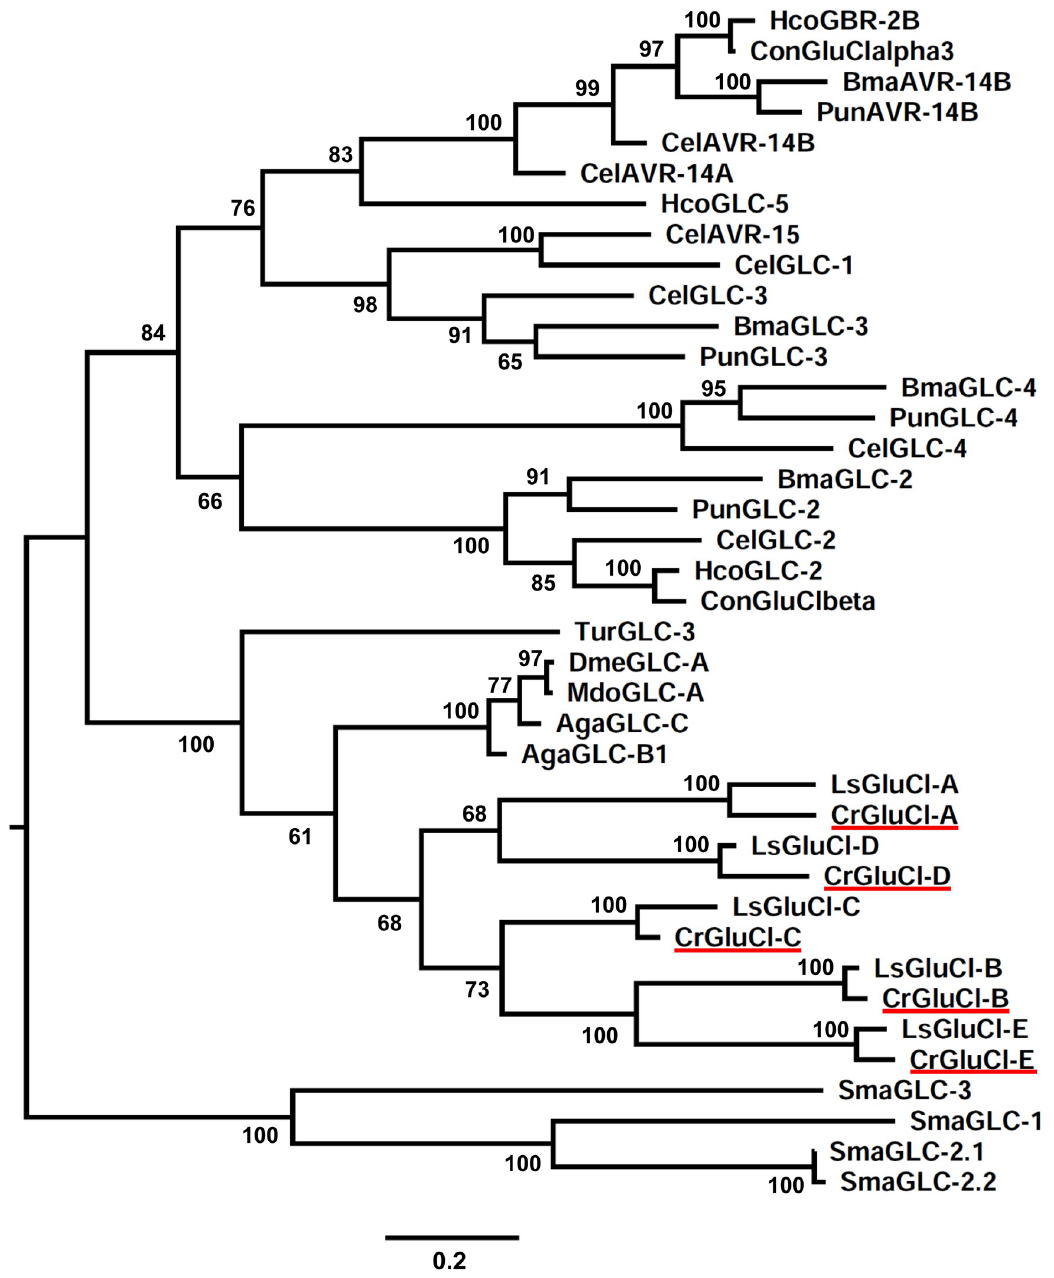
Fig 2. Phylogenetic analysis of CrGluCl subunits. Maximum likelihood tree showing the evolutionary relationship of C . rogercresseyi GluCl subunits (underlined in red) compared to other arthropods and nematodes CrGluCl counterparts. The percentage of trees in which the associated taxa clustered together is shown next to the branches (100 bootstrap replicates). The tree is drawn to scale, with branch lengths measured in the number of substitutions per site (scale bar). The analysis involved 39 amino acid sequences. The GenBank accession numbers of the amino acid sequences are given in the Methods section. Evolutionary analyses were conducted in MEGA11 [55]. The GluCl subunits of the platyhelminth Schistosoma mansoni (SmaGluCl-1, SmaGluCl-2, SmaGluCl-3 and SmaGluCl-4) were used as control since they belong to an independent GluCl clade evolutionarily distinct from arthropod and nematode counterparts